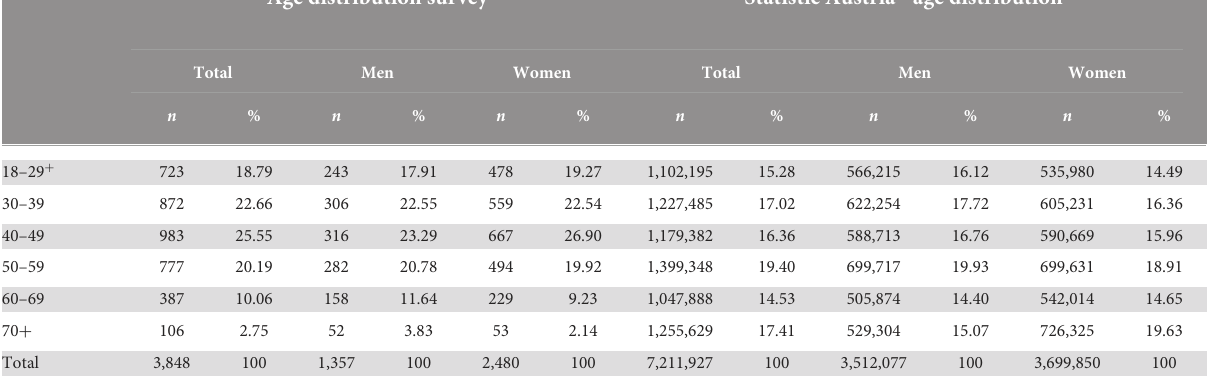
TABLE 1 Age distribution in the survey and the official Austrian